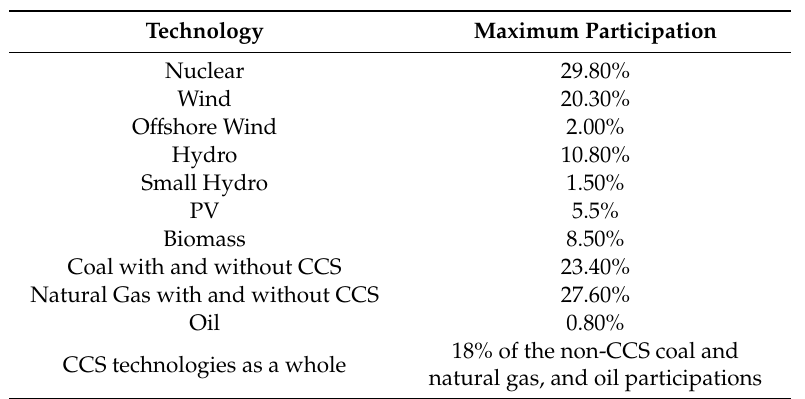
Table 3. Limits by generation technology. Source: Authors’ own work, based on data collected from DeLlano et al. (2015)